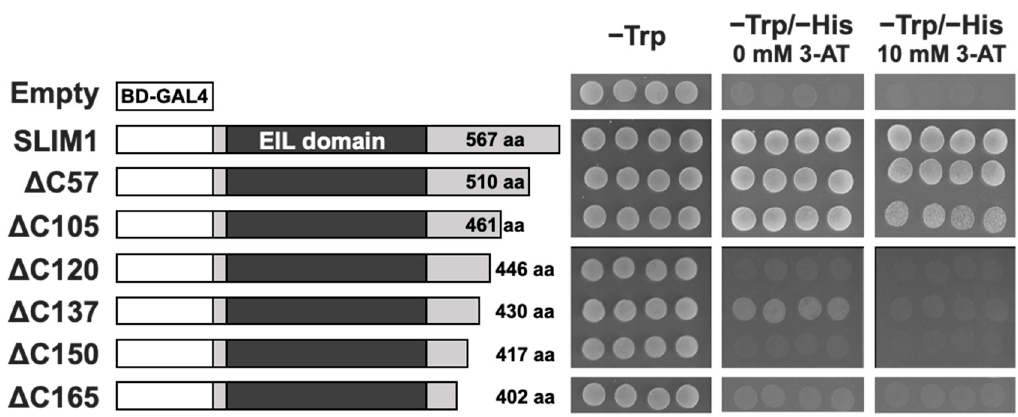
Figure 2. Trans-activation of HIS3 gene expression in yeast. The left panel shows the schematic representations of SLIM1 proteins fused to the GAL4 DNA-binding domain (BD-GAL4). Empty: no insertion, SLIM1: full-length SLIM1, Δ C57, Δ C105, Δ C120, Δ C137, Δ C150, and Δ C165: C-terminal truncated forms of SLIM1 lacking the C-terminal 57, 105, 120, 137, 150, and 165 amino acids, respectively. BD-GAL4: DNA binding domain of yeast GAL4 protein. Four independent colonies obtained from each plasmid transformation of yeast strain AH109 were spotted on the minimal SD agar medium lacking Trp ( − Trp) or Trp and His ( − Trp/ − His) with or without 10 mM 3-amino-1,2,4-triazole (3-AT). The right panel shows the yeast growth at 30 °C for 3 days after spotting.